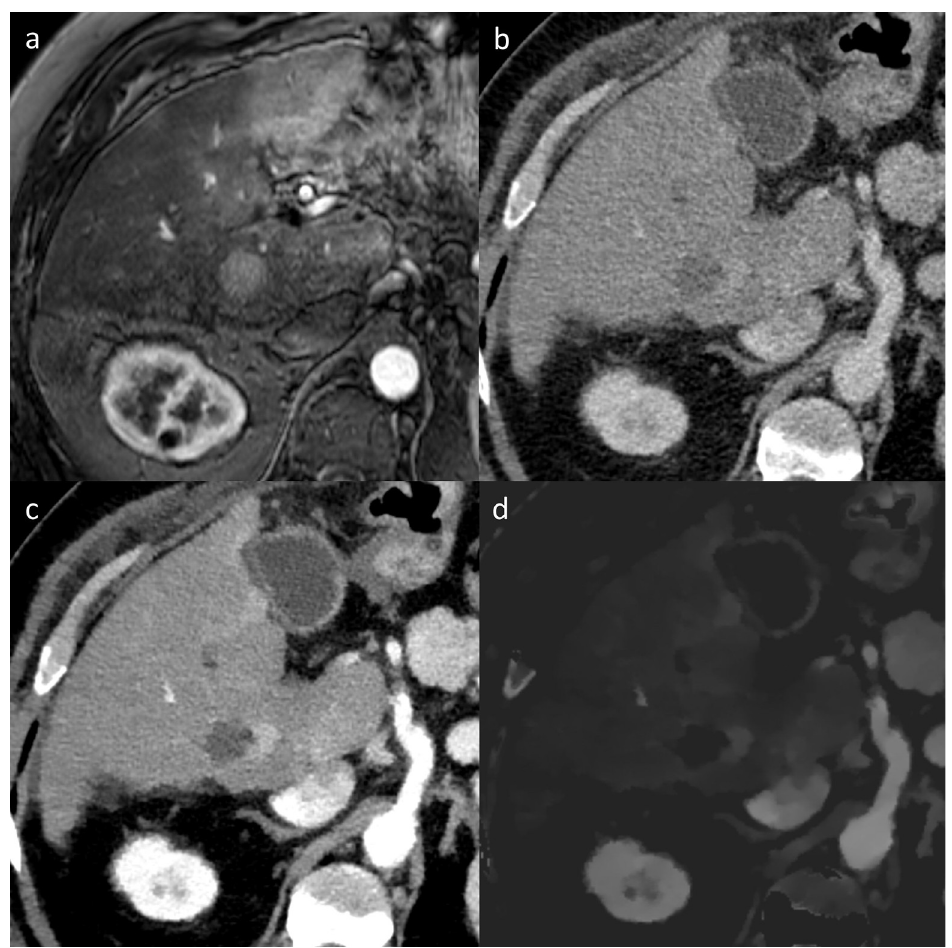
Fig 4. Image examples illustrating the value of spectral detector computed tomography (SDCT) after microwave ablation (MWA) of hepatocellular carcinoma (HCC). The pre-operative magnetic resonance scan clearly shows the arterially hyper-enhancing HCC in liver segment V (a). In the early follow up after incomplete MWA, the detection of residual tumor (RT) is hampered in conventional images (b) due to the poor contrast of the ablation zone and adjacent RT. Using SDCT, RT and thus incomplete ablation can be better depicted by means of low-keV virtual monoenergetic images (50 keV in c) and iodine maps